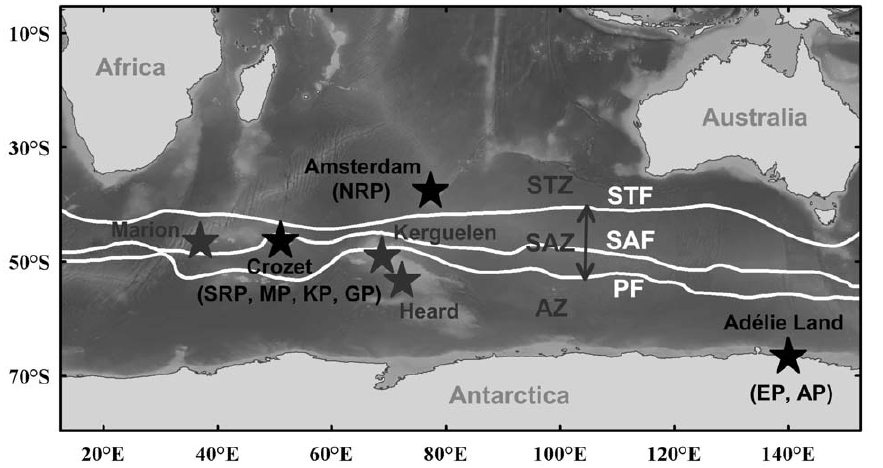
Figure 1. Map of the southern Indian Ocean with the main islands, oceanic fronts and zones. In black, sampling localities, with the sampled penguin species in parentheses. Abbreviations: NRP, northern rockhopper penguin; SRP, southern rockhopper penguin; MP, macaroni penguin; KP, king penguin; GP, gentoo penguin; EP, emperor penguin; AP, Ade´lie penguin; STF, Subtropical Front; SAF, Subantarctic Front; PF, Polar Front; STZ, Subtropical Zone; SAZ, Subantarctic Zone; AZ, Antarctic Zone